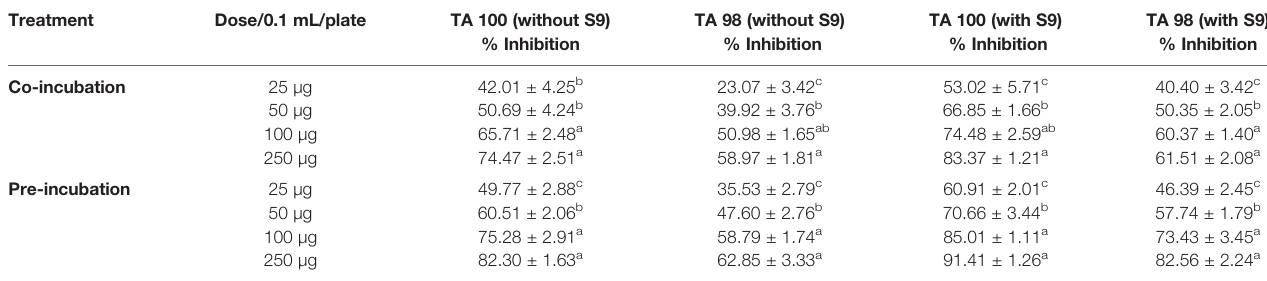
TABLE 1 | Percentage inhibition of mutagenicity by Obeth extract of O. bracteata in TA98 and TA100 tester strains of Salmonella typhimurium with and without S9. Treatment